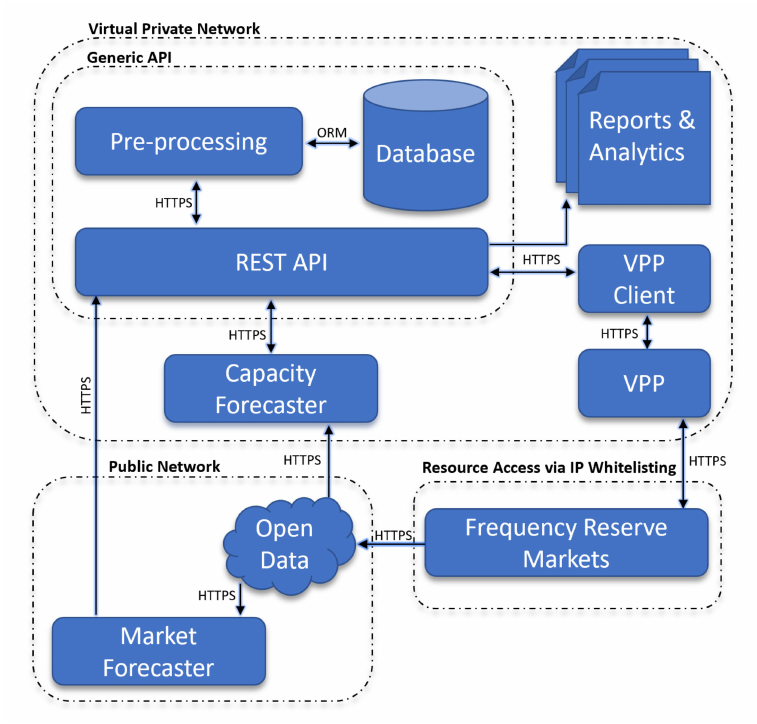
Figure 1. Overview of the architecture of the proposed generic VPP